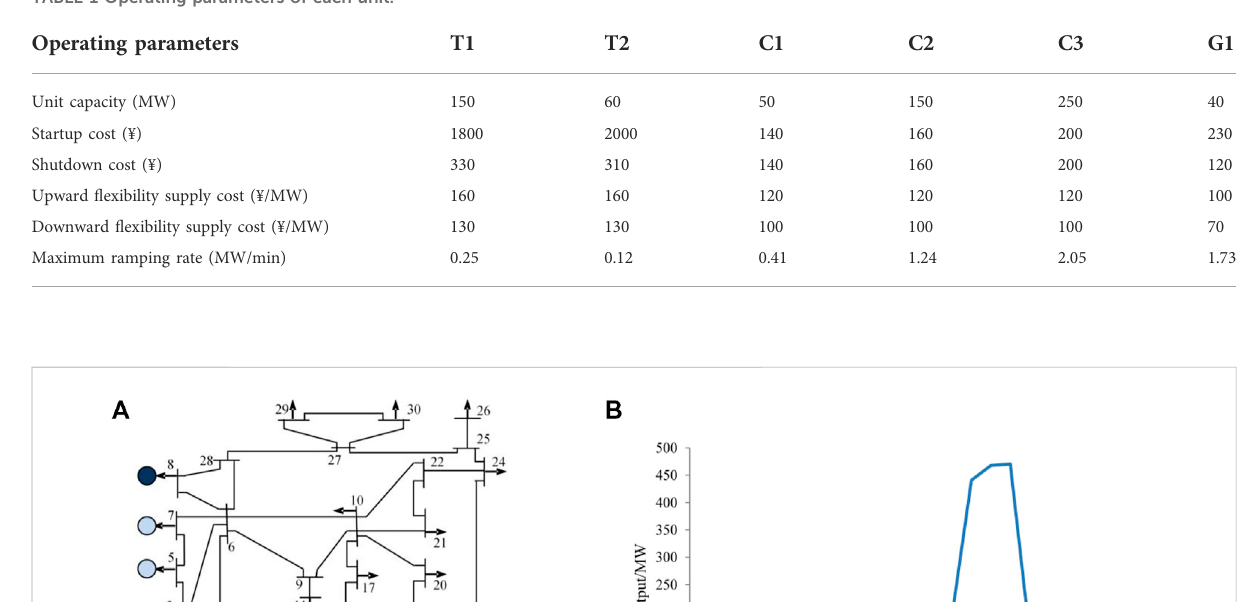
TABLE 1 Operating parameters of each unit.